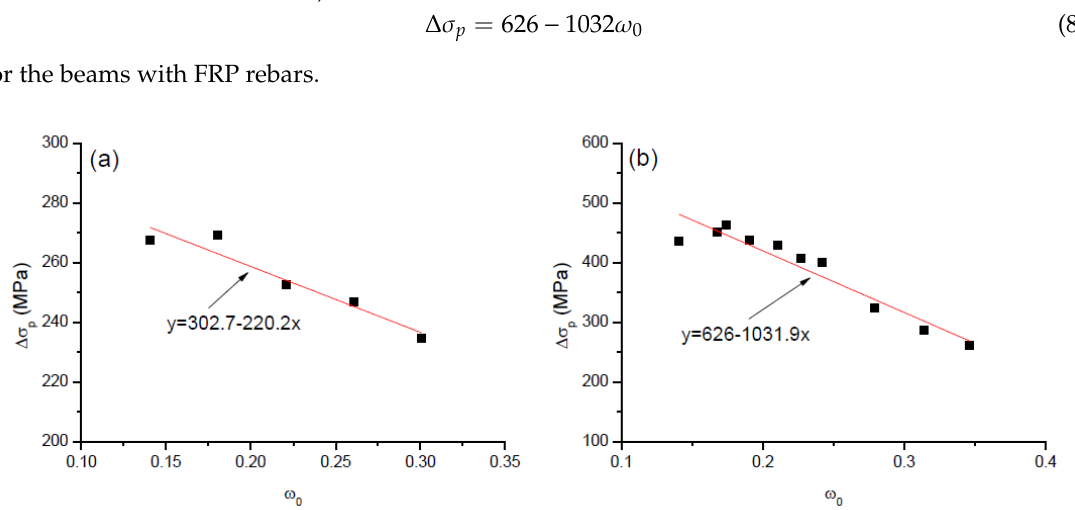
Figure 11. Linear fit to the numerical data. ( a ) beams with steel rebars; ( b ) beams with FRP rebars.